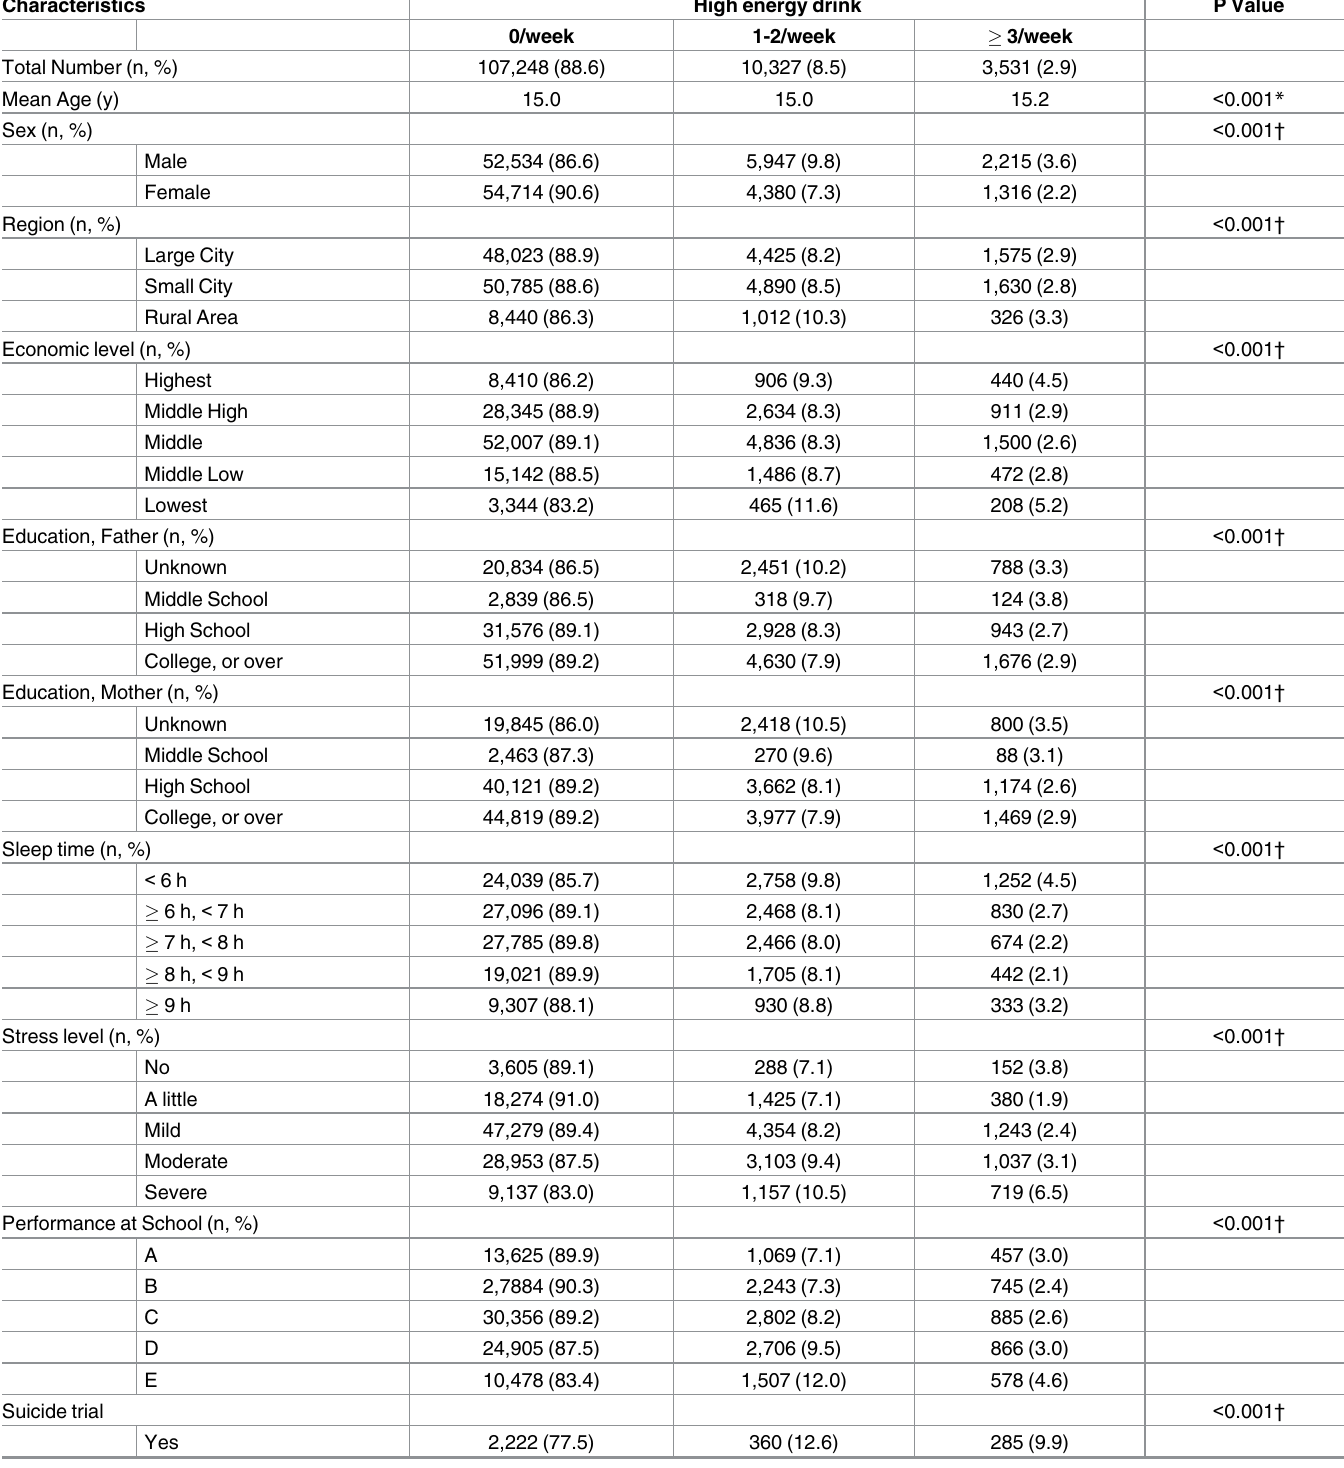
Table 1. General characteristics of participants according to energy drinks consumption.